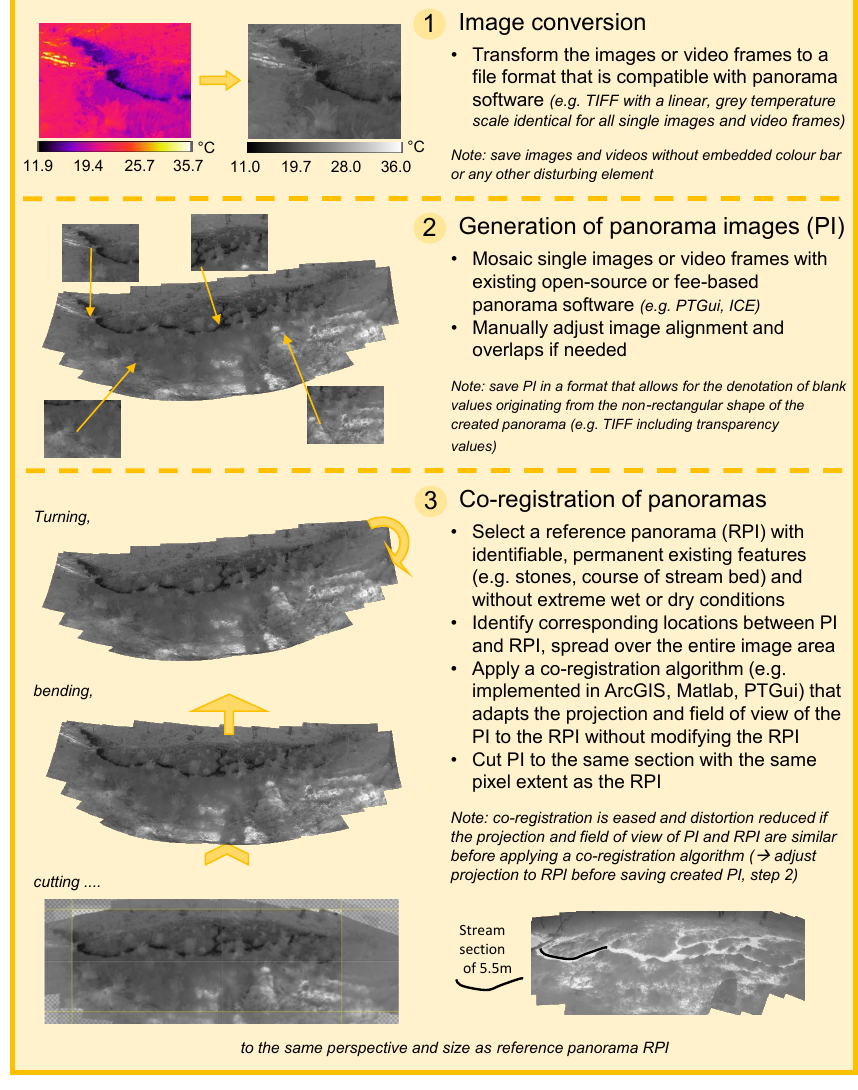
Figure 3. Workflow for processing single TIR images and video frames to co-registered panoramic